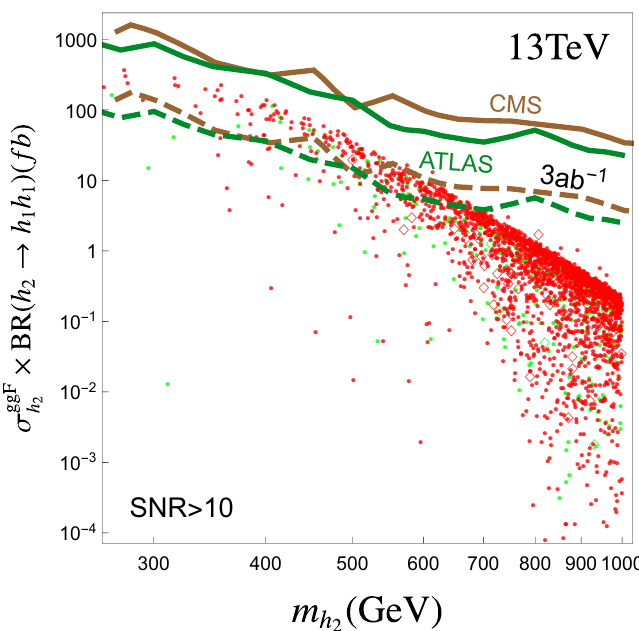
Figure 9 . The upper limits on di-Higgs resonant production cross section from ATLAS and CMS combined searches, shown as solid green and brown lines for ATLAS and CMS, respectively. The dashed lines denote the corresponding future projections for 3 ab (cid:0) 1 of data at the HL-LHC (13 TeV). As in the other plots, we distinguish those points which give SNR > 50 (red) and those of 50 > SNR > 10